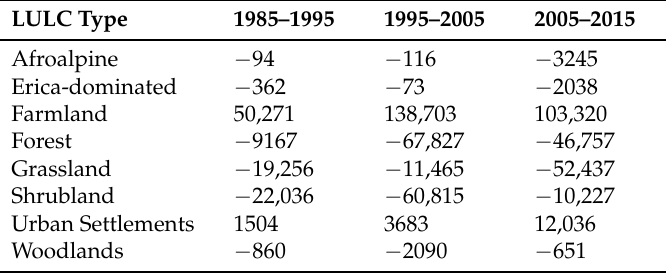
Table 4. Extent of LULCC (area in ha) during 1985–2015.